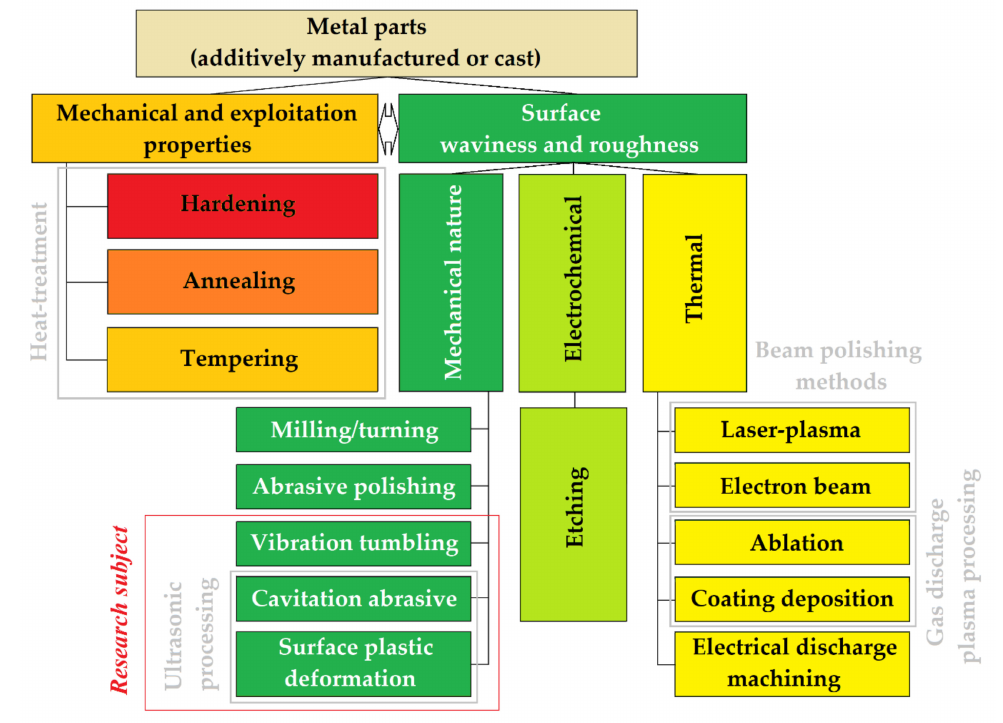
Figure 1. Postprocessing methods for metal